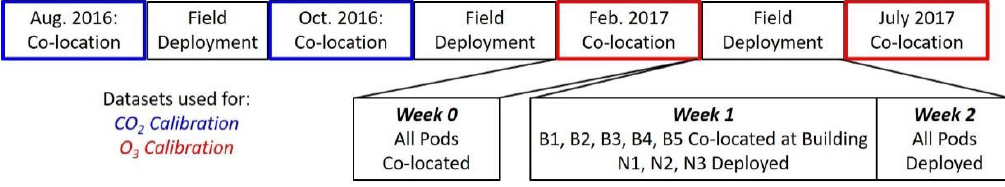
Figure 2. Timeline showing when co-location of sensors with reference instruments occurred and when deployments to field sites occurred. deployments to field sites